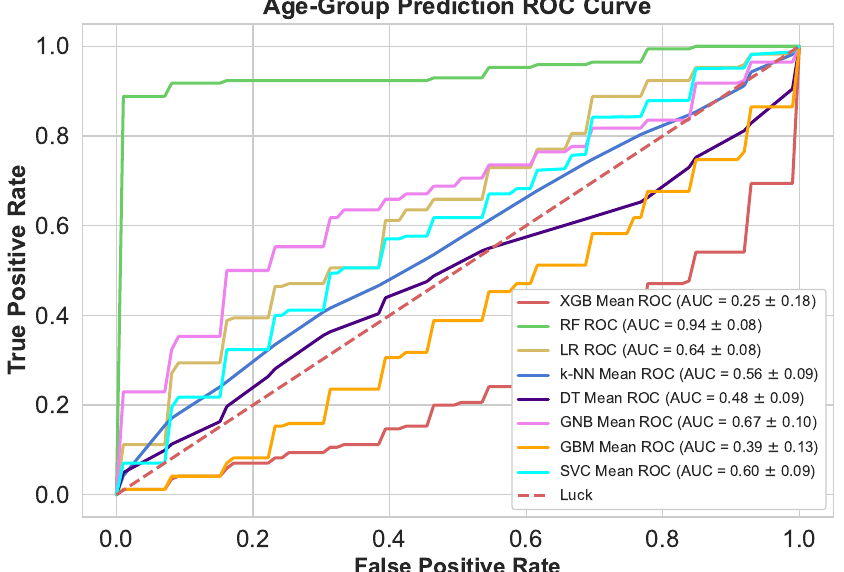
Figure 9. Age Group classifier’s ROC’s at dynamic